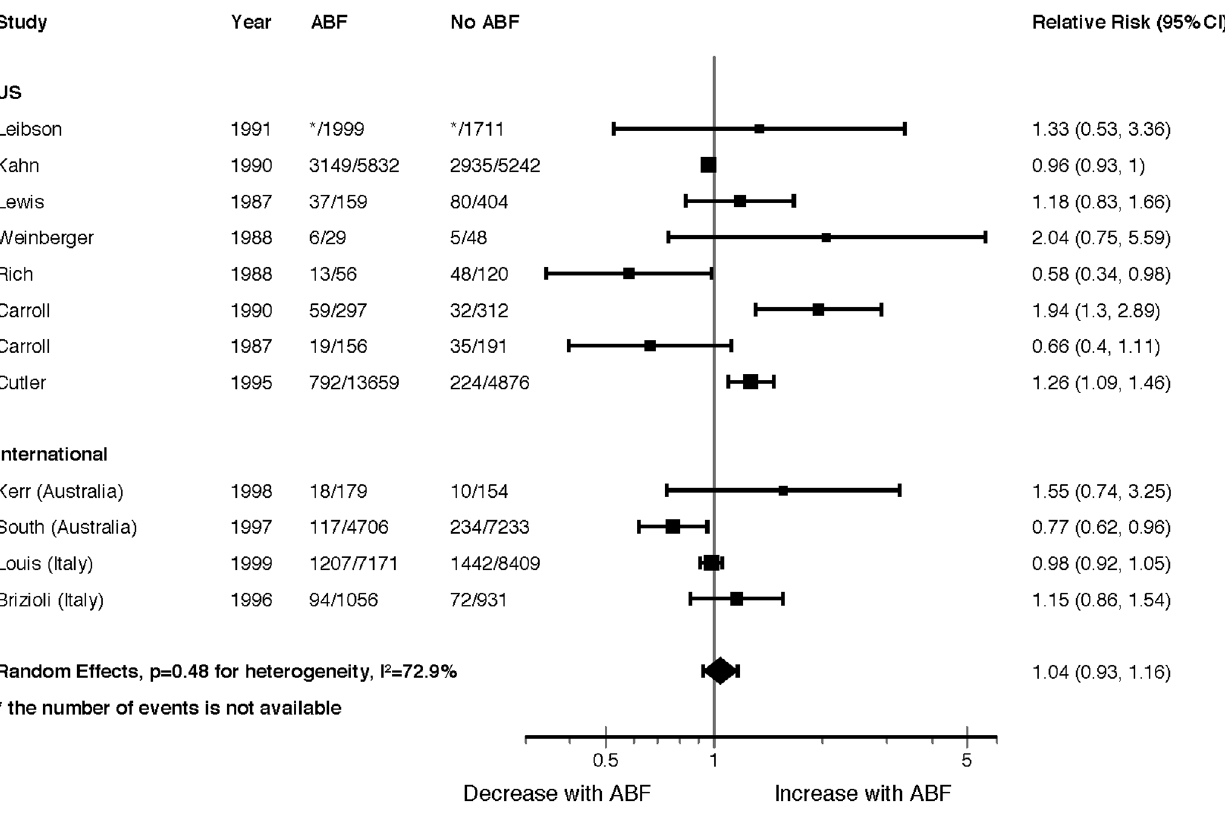
Figure 3. Readmission Forest Plot.